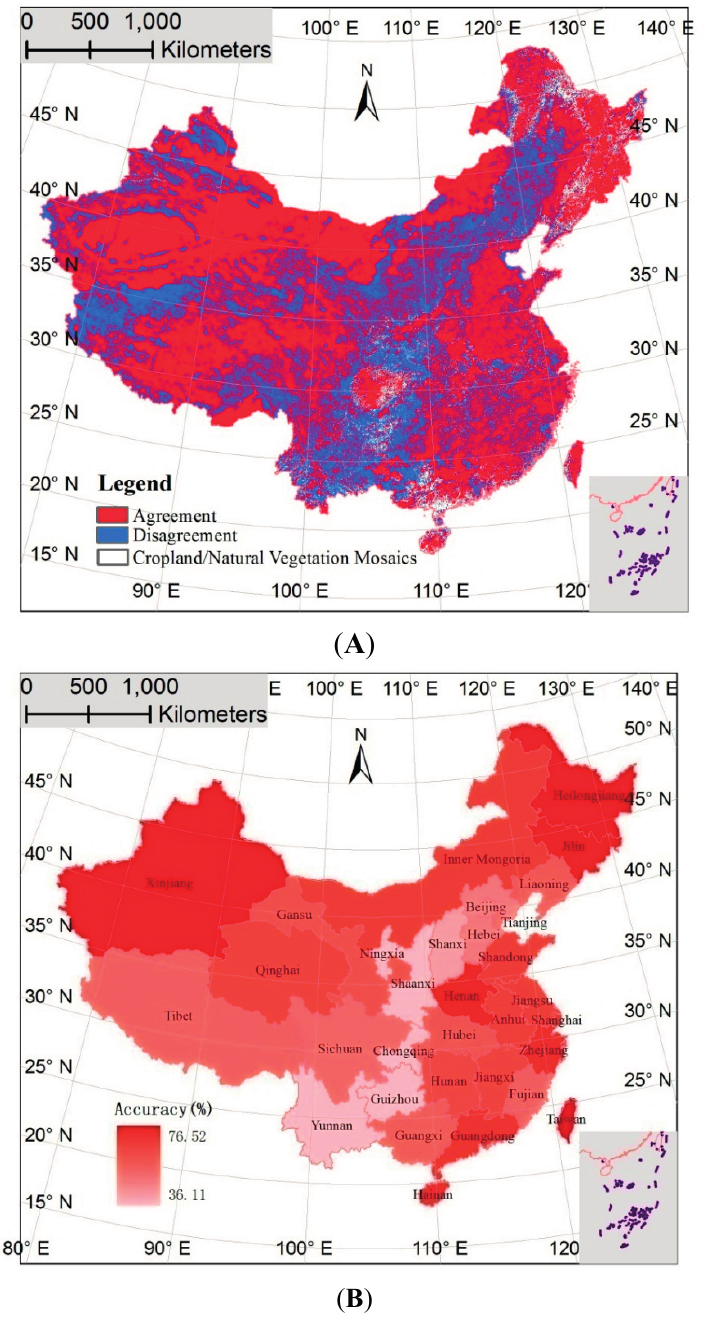
Figure 4. The distributions of the spatial consistencies between the classification and reference data and the overall accuracies of the 32 provinces based on the 100-m reference data. ( A ) Agreement and disagreement. ( B ) Accuracies for the 32